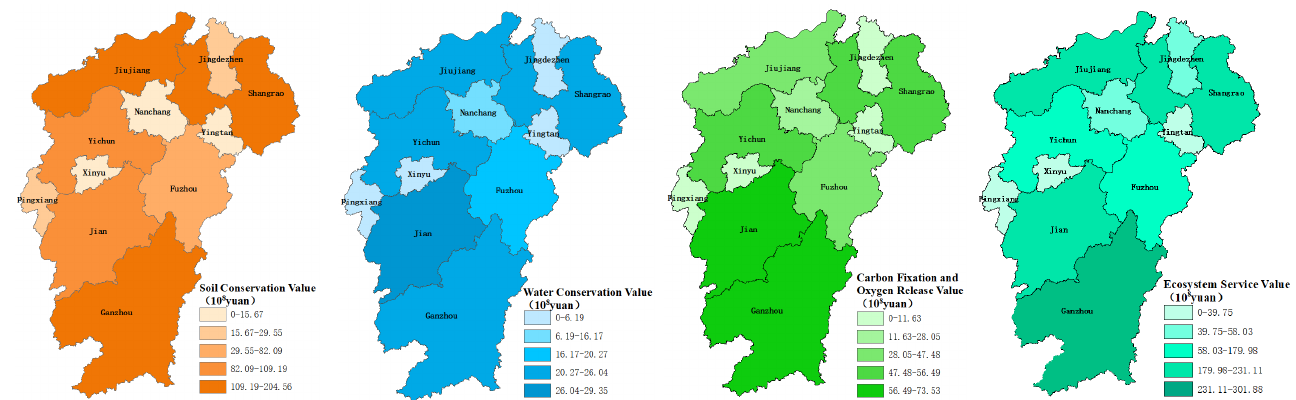
Figure 2. Spatial distribution map of total value of cultivated land resource asset ecosystem service function.